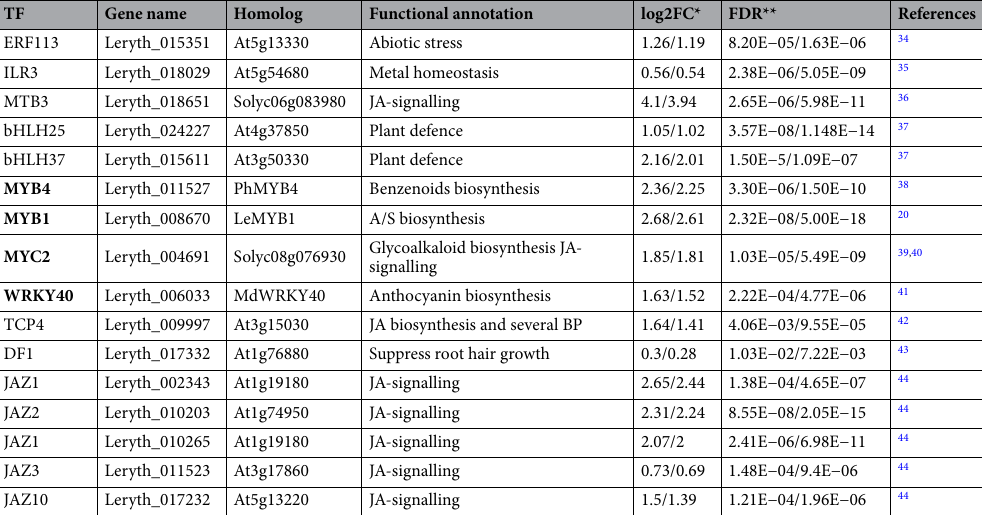
Table 2. Putative regulators of A/S biosynthesis in Lithospermum officinale . Transcription factors (TFs) coexpressed with LePGT1 in the red subnetwork. TFs which have been previously demonstrated to regulate SM biosynthesis in other plant species are highlighted in bold. *log2FC = log2 fold change, values above and below the/are from edgeR and DESeq2, respectively. **FDR = False discovery rate, values above and below the/ are from edgeR and DESeq2,